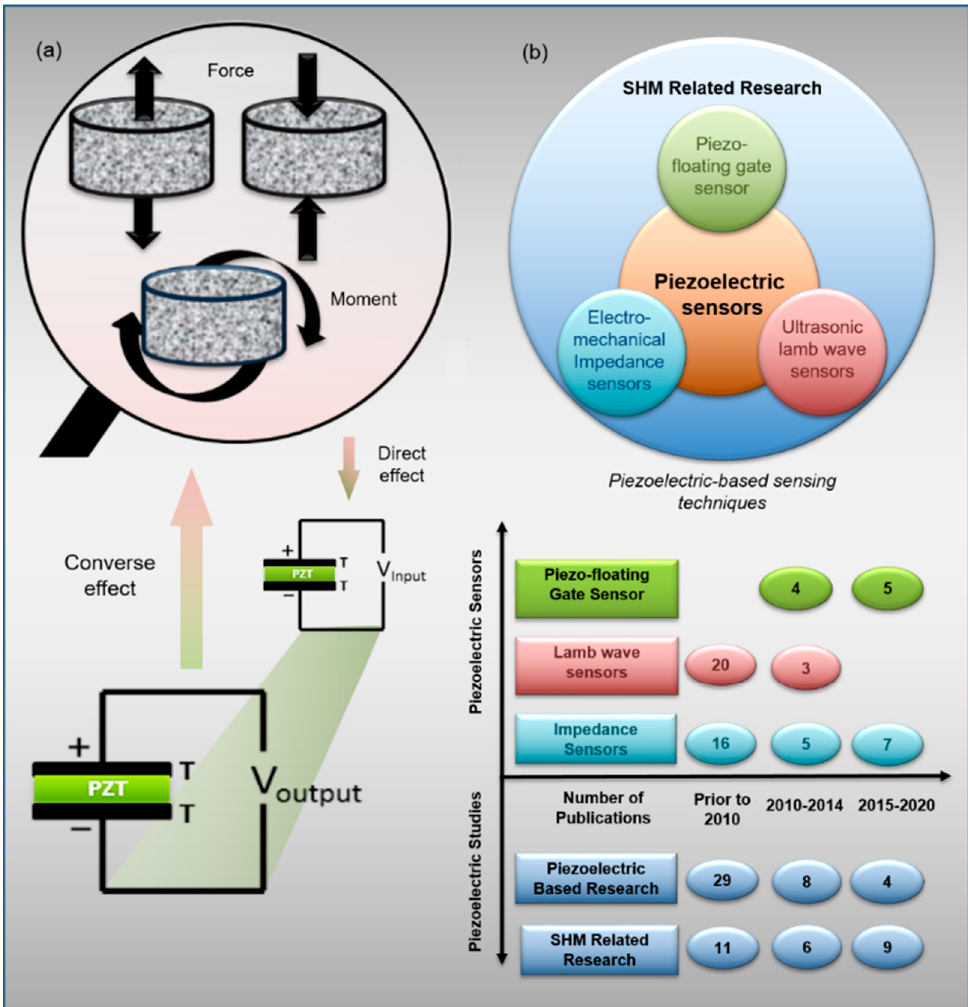
Figure 1. ( a ) Principle of the direct and inverse response in the piezoelectric effect, and ( b ) Summary of the studies in the piezoelectric-enabled sensing techniques in structural health monitoring (SHM).